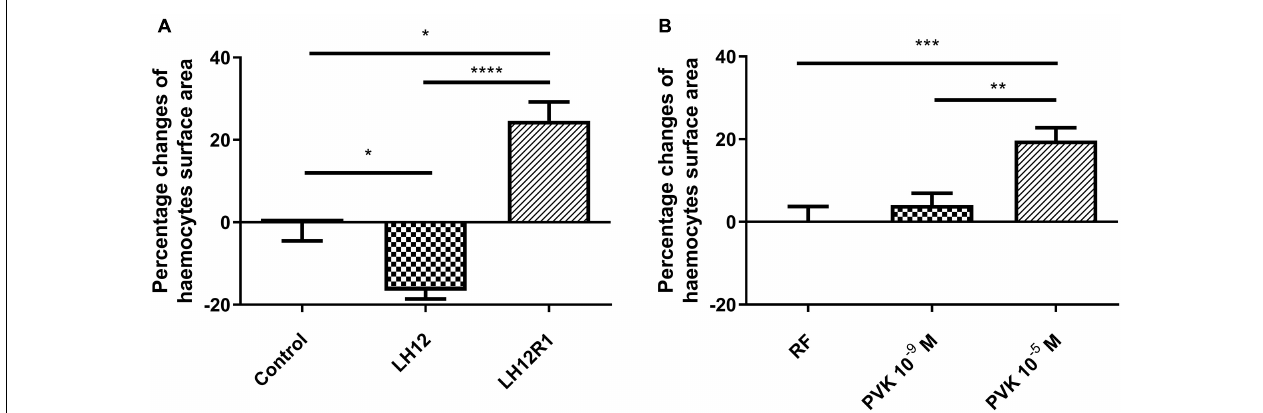
FIGURE 3 | Percentage changes of haemocyte surface area of N. vespilloides compared to untreated individuals (control) or individuals injected with physiological saline (PS) (A) LH12: beetles exposed to low humidity for 12 h; LH12R1: beetles exposed to low humidity and recovered for 1 h; PVK 10 − 9 M and PVK 10 − 5 M: beetles analyzed 1 h after injection of Tenmo–PVK-2 at concentrations of 10 − 9 and 10 − 5 M, respectively (B) . Mean ± SEM, * p ≤ 0.05, ** p ≤ 0.01, *** p ≤ 0.001, **** p ≤ 0.0001.